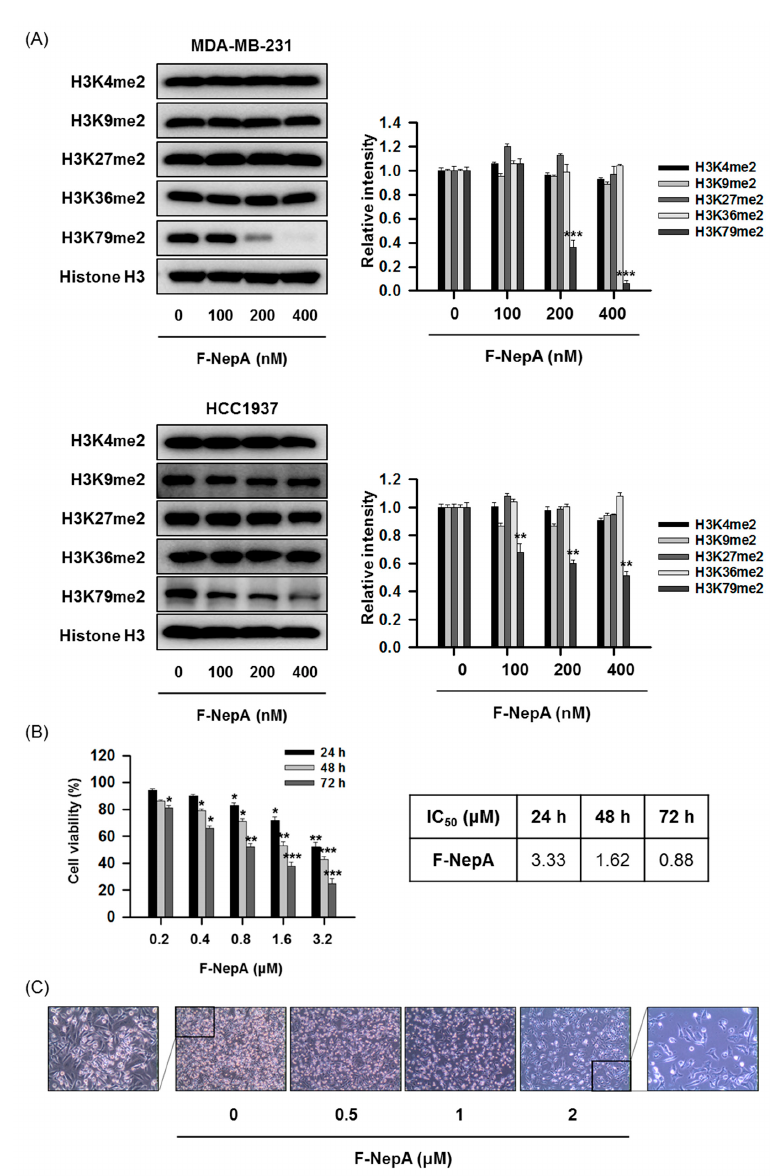
Figure 3. Effects of F-NepA on the methylation of various H3 lysine residues and viability in human TNBC cells. ( A ) MDA-MB-231 and HCC1937 cells were treated with the indicated concentrations of F-NepA for 48 h, and the methylation levels of various H3 lysine residues were determined by Western blotting. Histone H3 was used as an internal control. The relative intensities of the indicated proteins were analyzed semi-quantitatively using NIH ImageJ software. ( B ) MDA-MB-231 cells were incubated with the indicated concentrations of F-NepA for 24–72 h, after which cell viability was measured using an MTT assay. Data are expressed as means ± SD from three independent experiments. The IC 50 values were calculated via a nonlinear regression analysis using TableCurve 2D v5.01 software. ( C ) Morphological changes in MDA-MB-231 cells induced by F-NepA (0–2 µ M) were viewed under an inverted phase-contrast microscope (100 × magnification). All data are expressed as mean values ± SD (n = 3) and are representative of three separate experiments. * p < 0.05, ** p < 0.01, and *** p < 0.001 indicate significant di ff erences relative to the vehicle-treated control